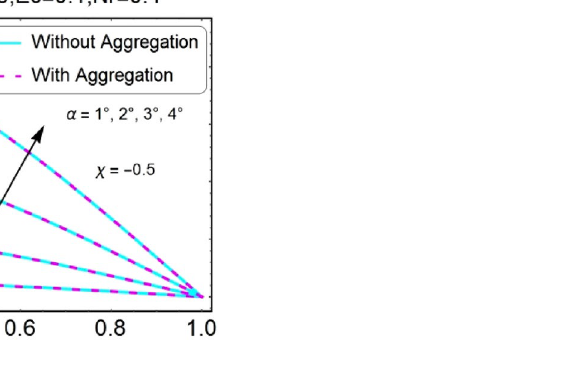
Figure 12. α varying θ for shrinking walls (divergent